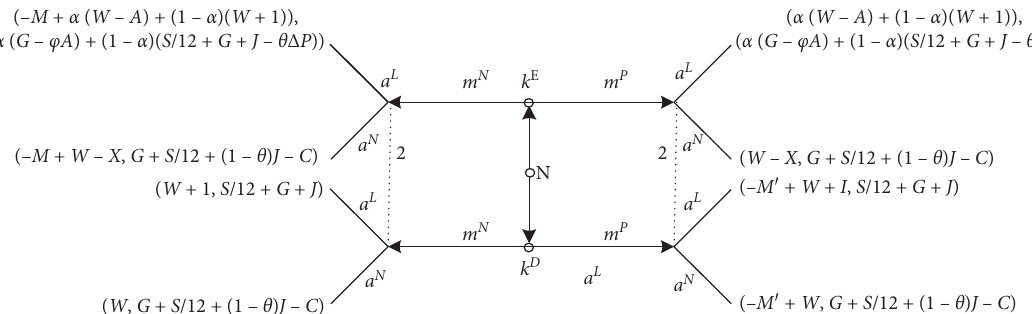
Figure 3: Signal game model of the miners and managers from the perspective of